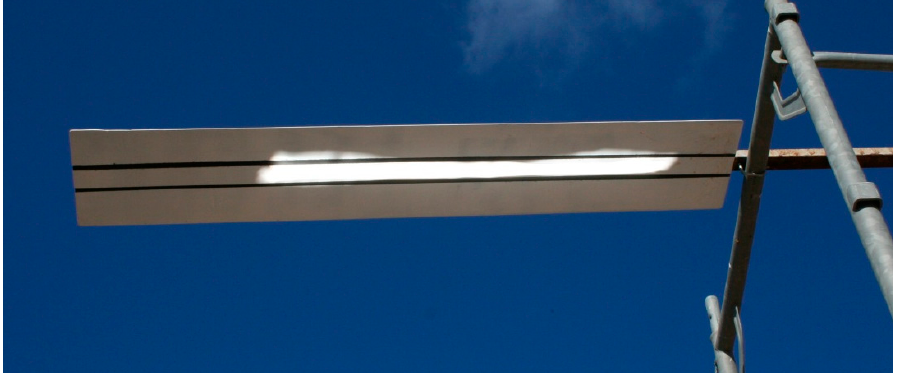
Figure 12. Concentrated radiation reflected into a Lambertian target.